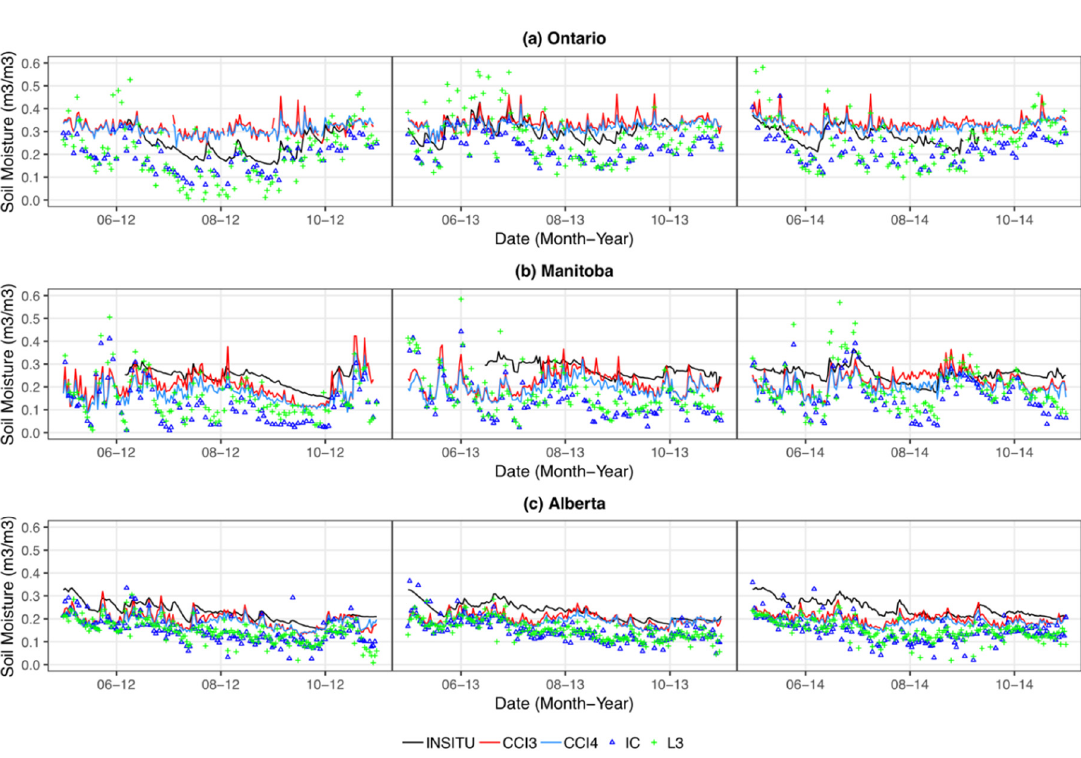
Figure 2. Time series of in situ, CCI3, CCI4, IC and L3 absolute surface soil moisture for the months May to October for a three-year evaluation period (2012–2014) at ( a ) Ontario, ( b ) Manitoba, ( c ) Alberta. Soil moisture data shown for each region are averages of all stations for each respective region.